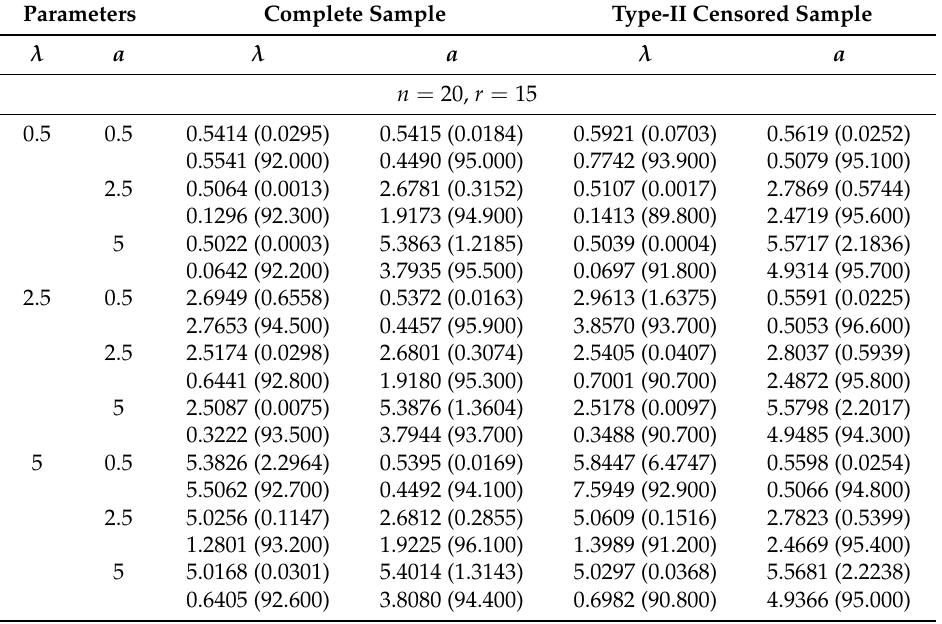
Table 2. The AVs of estimates and corresponding MSEs (in parentheses) in the first row and the CIL and corresponding coverage probability (in parentheses) in the second